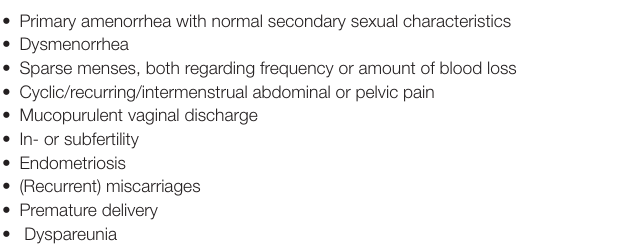
TABLE 2 | Overview of symptoms suspicious for a Müllerian anomaly in girls with a